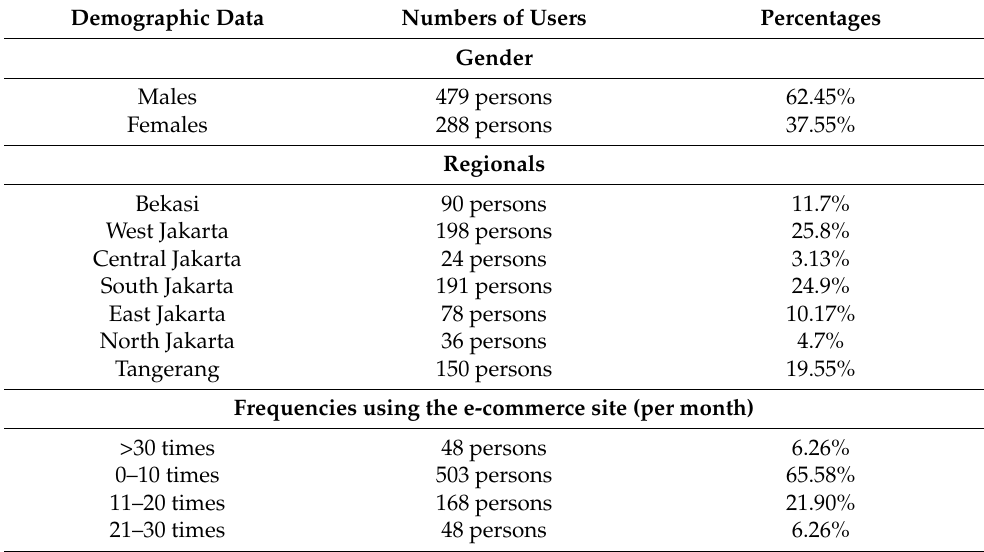
Table 2. Sample characteristics.